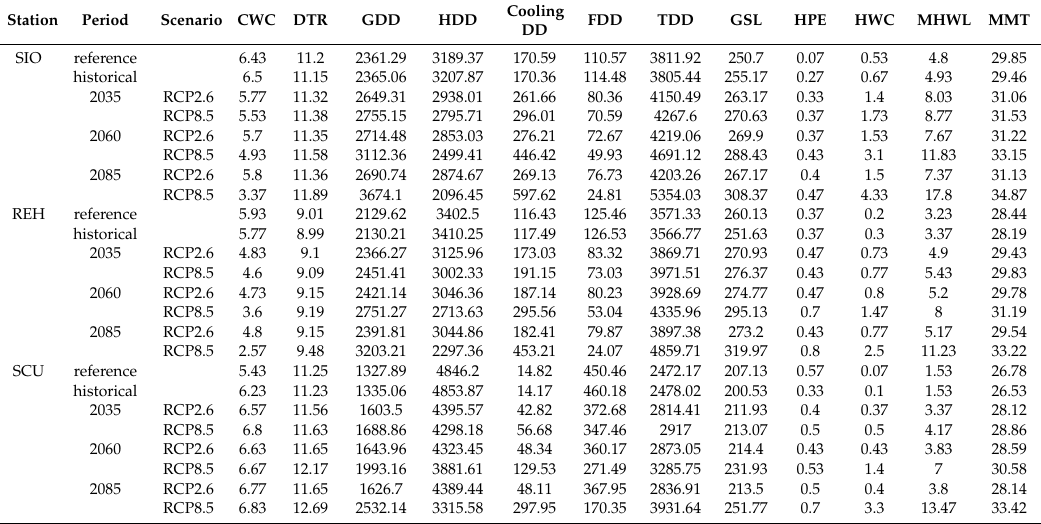
Table A1. Median values for class A indices as represented by observations (reference) and by the quantile-mapped CH2018 data for all time periods (historical, 2035, 2060 and 2085) and the two emission scenarios (RCP2.6 and RCP8.5) for the three representative stations SIO, REH and SCU.